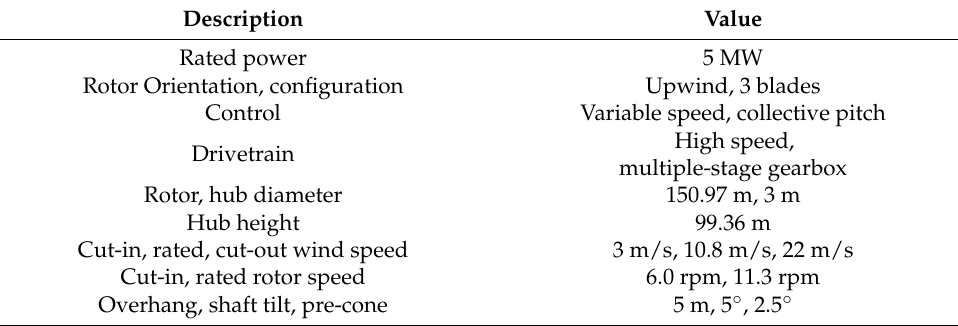
Figure 3. Schematic layout of 5 MW floating offshore wind turbine system. ( a ) Base layout of a wind turbine; ( b ) Base layout of a spar platform. Table 1. Overall key specification of 5 MW FOWT.